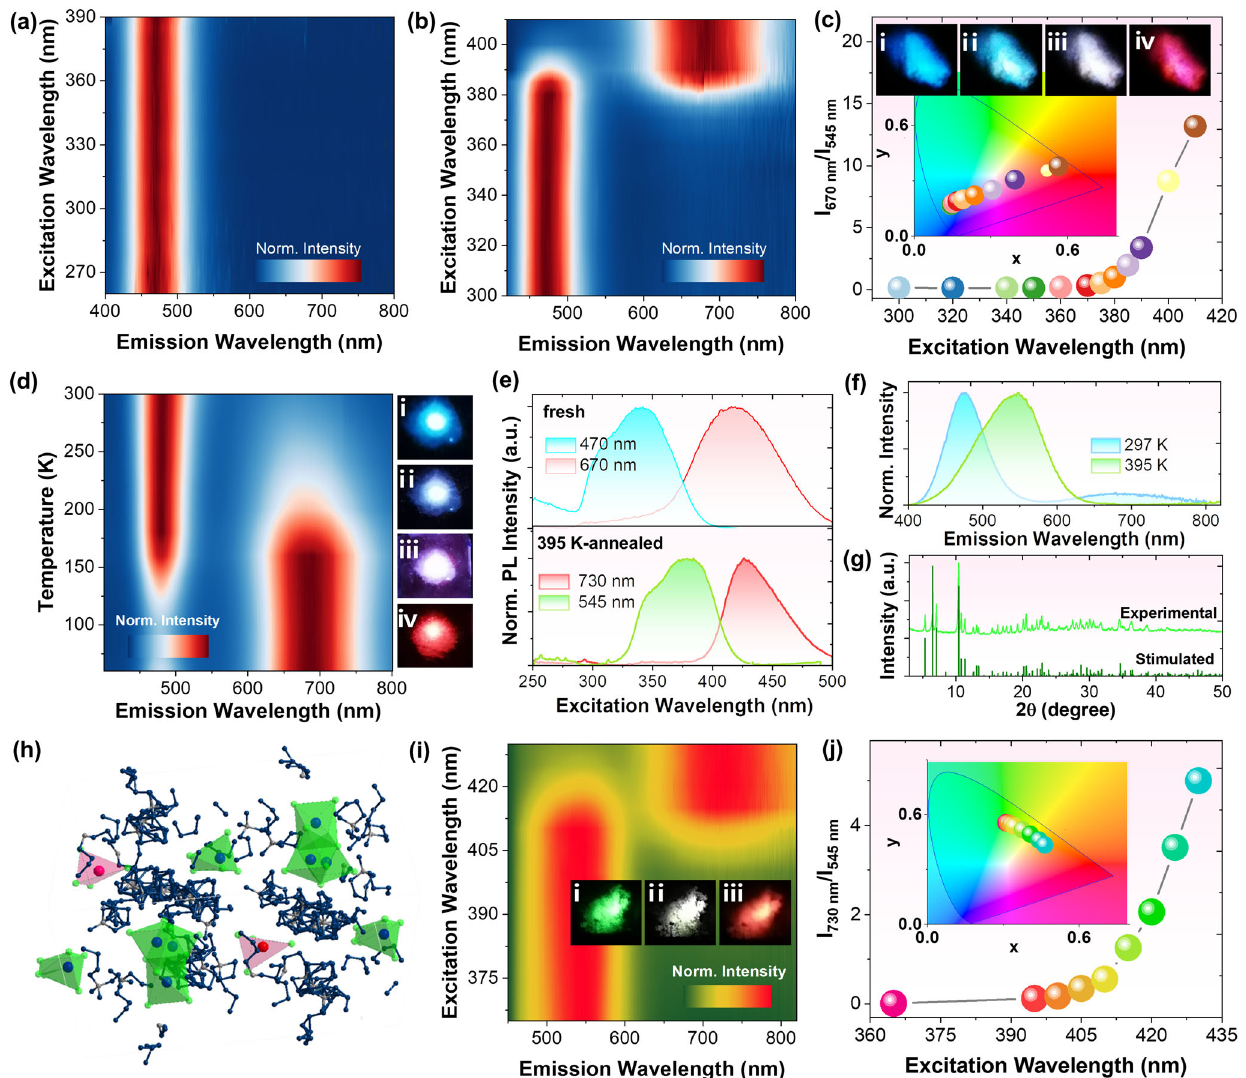
Fig. 2 Dynamic emission properties. Pseudo color map of excitation-wavelength-dependent PL emission of Pb-Br ( a ) and Pb-Br: Sb ( b ) at room temperature. c Excitation-wavelength-dependent ratio of I 670 nm to I 470 nm in Pb-Br: Sb. Inset shows the CIE coordinates for emission spectra in ( b ), and the optical images of Pb-Br: Sb power excited at (i) 360, (ii) 370, (iii) 380 and (iv) 400 nm. d Pseudo color map of temperature-dependent PL emission of Pb-Br: Sb, and the optical images of 365-nm-excited Pb-Br: Sb at (i) 300, (ii) 200, (iii) 180 and (iv) 80 K. e PLE spectra of Pb-Br: Sb at 300 K and 395 K. f Steady state PL emission spectra of 365-nm-excited Pb-Br: Sb at 300 K and 395 K. g Comparison of PXRD pattern of 395 K-annealed Pb-Br: Sb and the high-temperature phase of Pb-Br. h A schematic view of Sb 3 + -doped (C 10 NH 22 ) 9 [Pb 3 Br 11 ] [PbBr 4 ] 2 crystal structure. i Pseudo color map of excitation-wavelength-dependent PL emission of 395 K-annealed Pb-Br: Sb. Inset is the optical images of 395 K-annealed Pb-Br: Sb under excitation at (i) 360, (ii) 400 and (iv) 420 nm. (j) Excitation-wavelength-dependent CIE coordinates and emission intensity ratio of 730/545 nm in fresh 395-K-annealed Pb-Br: